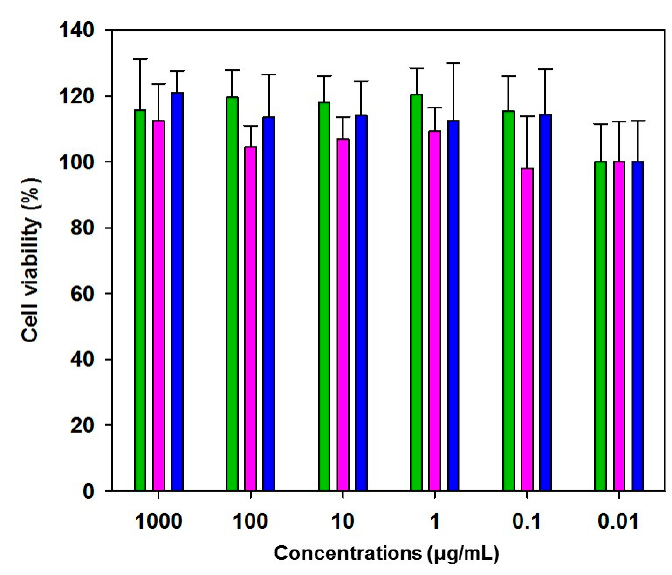
Figure 4. Cell viabilities of the MDA-MB-231 cells treated with various concentrations of the nanohydrogel (green: Nanohydrogel (A); magenta: Nanohydrogel (B); blue: Nanohydrogel (C)).